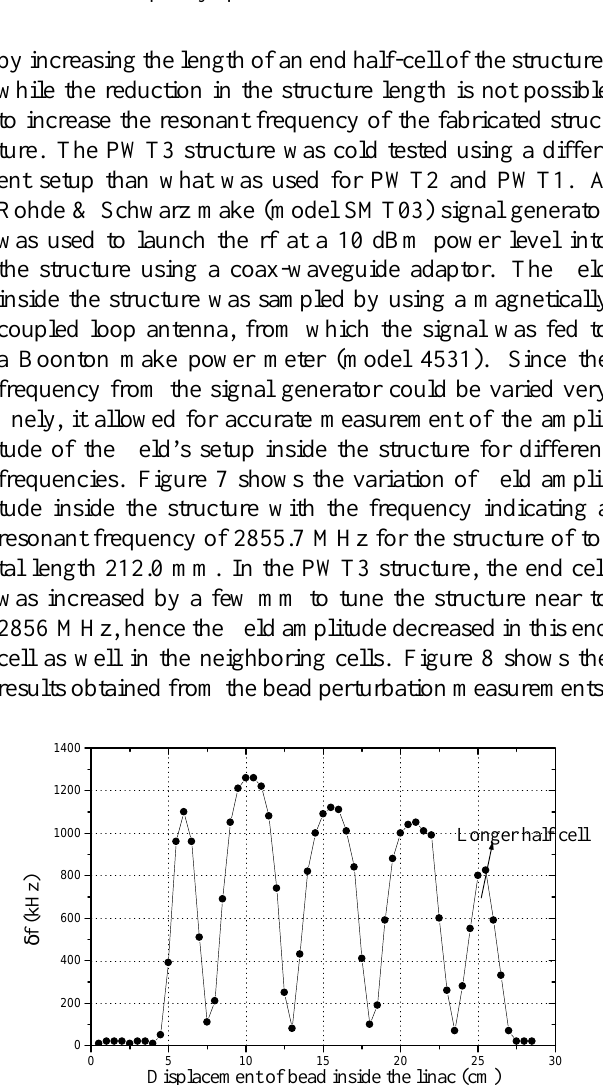
FIG. 7. Frequency spectrum of the PWT3 linac structure.